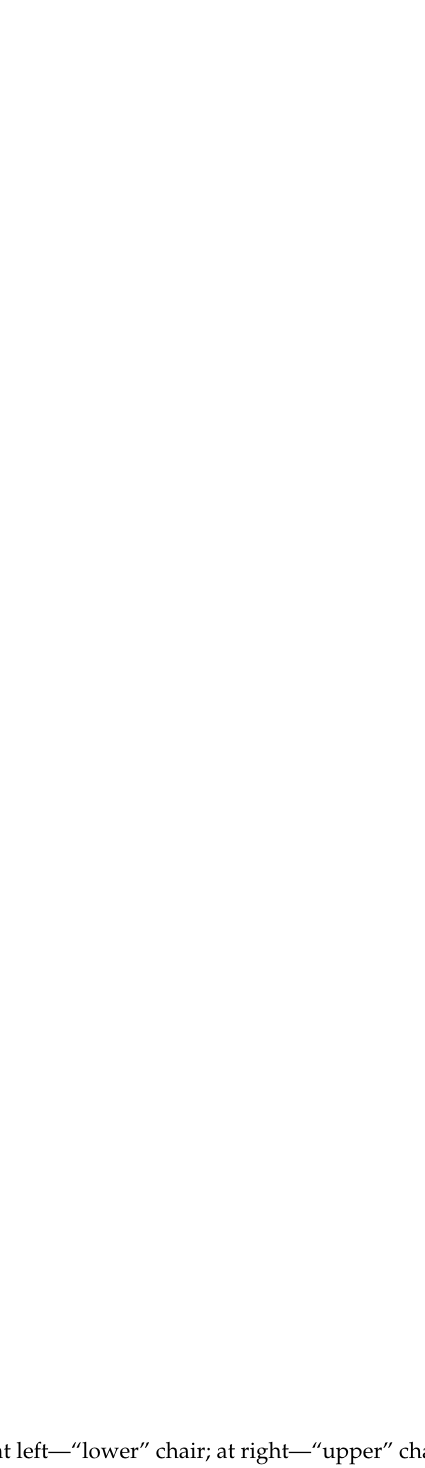
Figure 8. Chair positions for tilted falls considered (at left–“lower” chair; at right–“upper” chair).